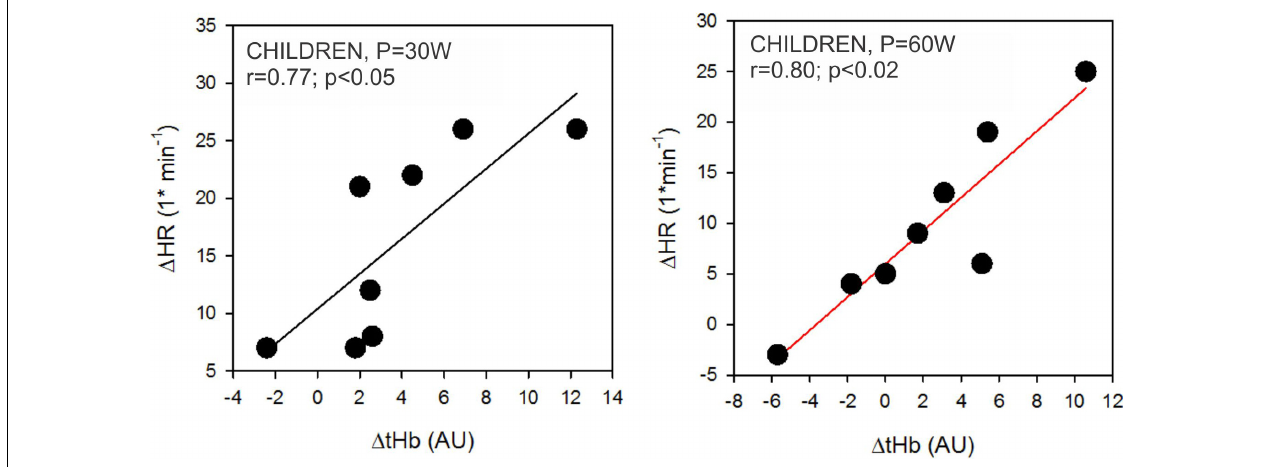
FIGURE 7 | Correlations between hypoxia-related changes in heart rate ( (cid:49) HR) and total hemoglobin concentrations ( (cid:49) tHb) in children. Correlations were only significant at 30 W and 60 W power outputs as outlined in the left and right panel,